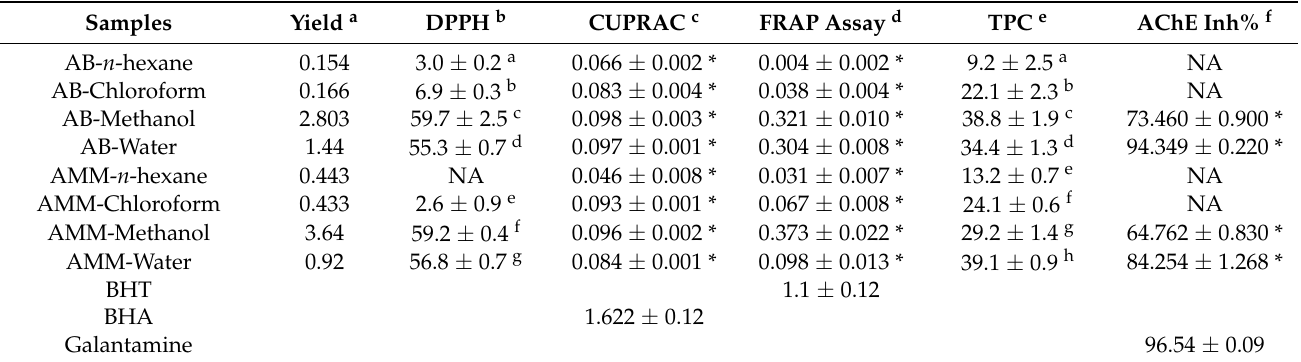
Table 1. Extract yield, total phenolic contents, antioxidant properties, and enzyme inhibition potential of the samples.